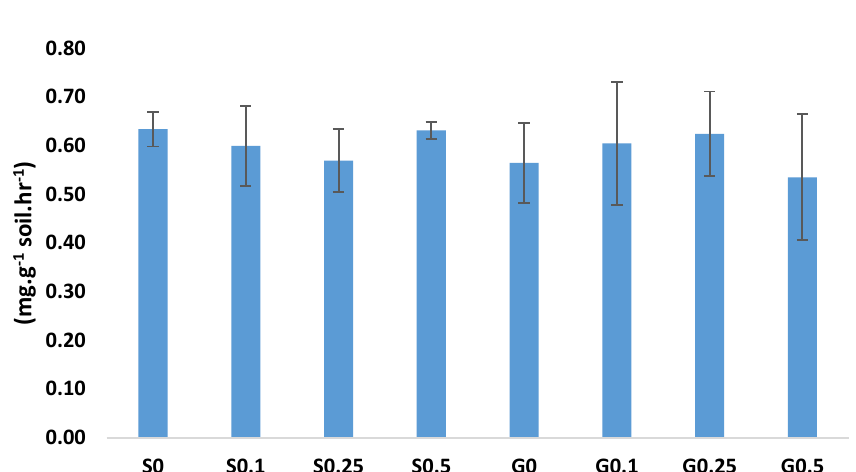
Figure 2. FDHA (mg g − 1 soil hr − 1 ) in soil without ryegrass (S0, S0.1, S0.25, S0.5) and with ryegrass (G0, G0.1, G0.25, G0.5) after irrigation by the biochar-treated wastewater at different concentrations (0, 0.1, 0.25 and 0.5 g L − 1 ). Values represent means ± standard deviations ( n = 4, p ≤ 0.05) .